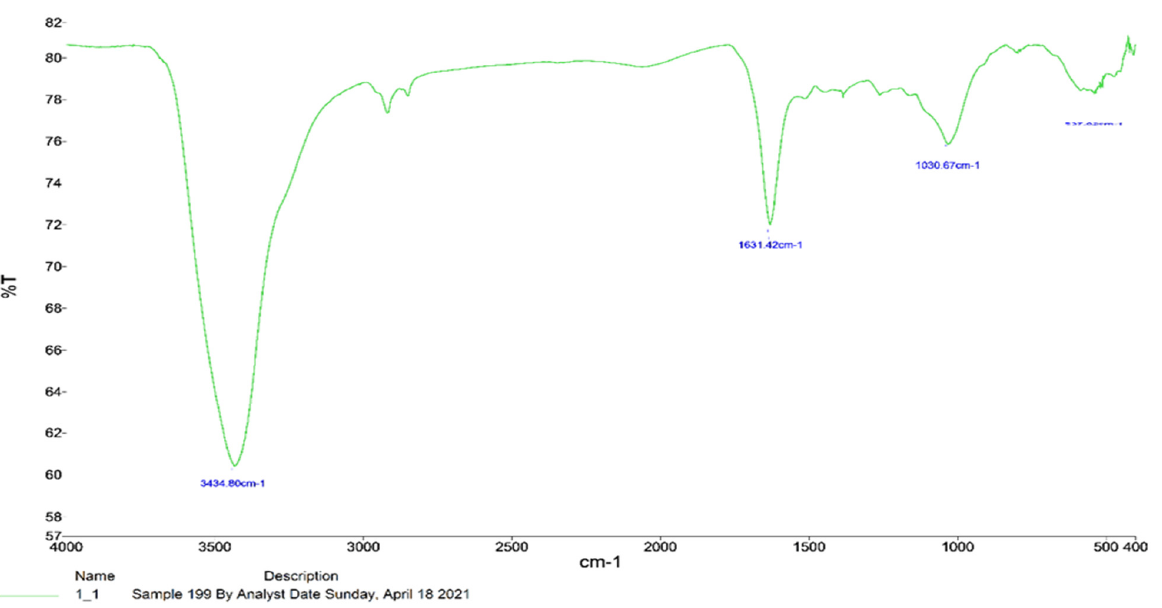
Figure 6. FTIR spectrum of O. majorana aqueous leaf extract.